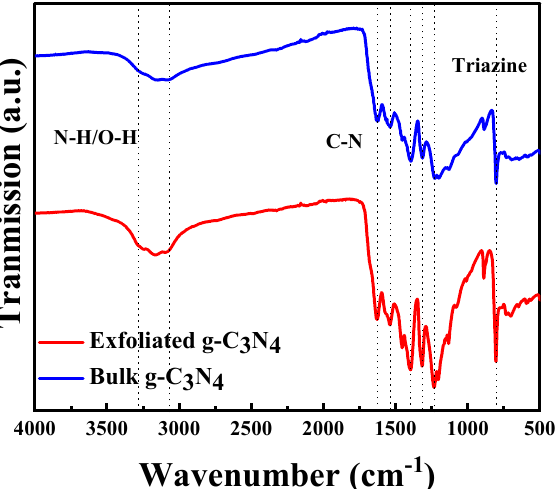
Figure 3. Fourier transform infrared spectra of bulk and exfoliated g-C 3 N 4 .